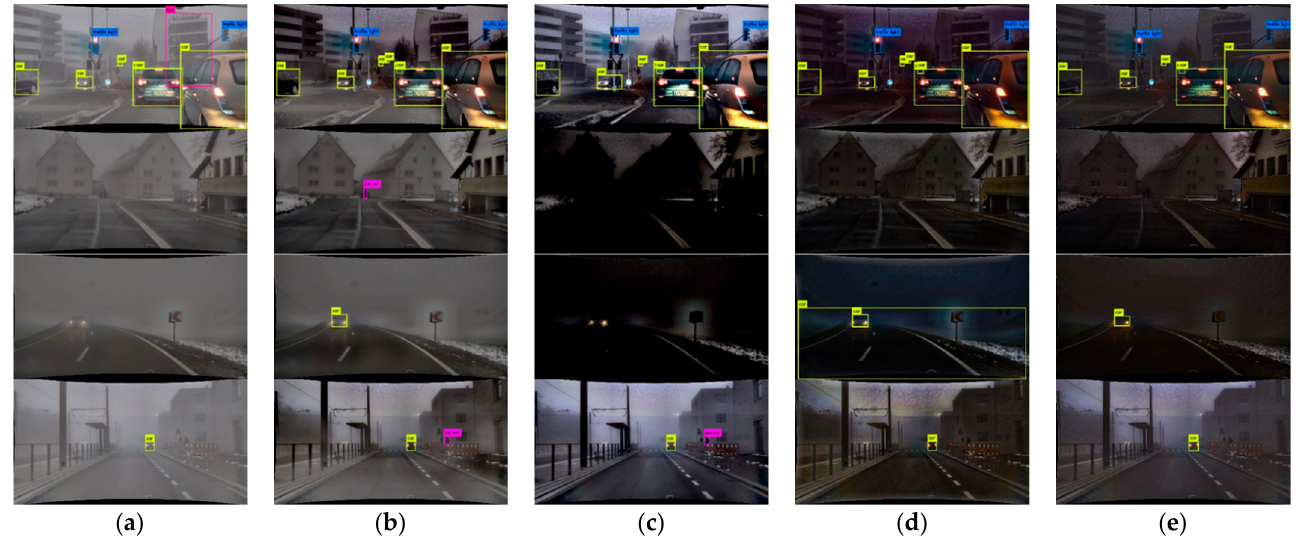
Figure 18. Qualitative comparison of various algorithms: ( a ) hazy input; ( b ) proposed; ( c ) Fattal; ( d ) He; ( e ) Tan.